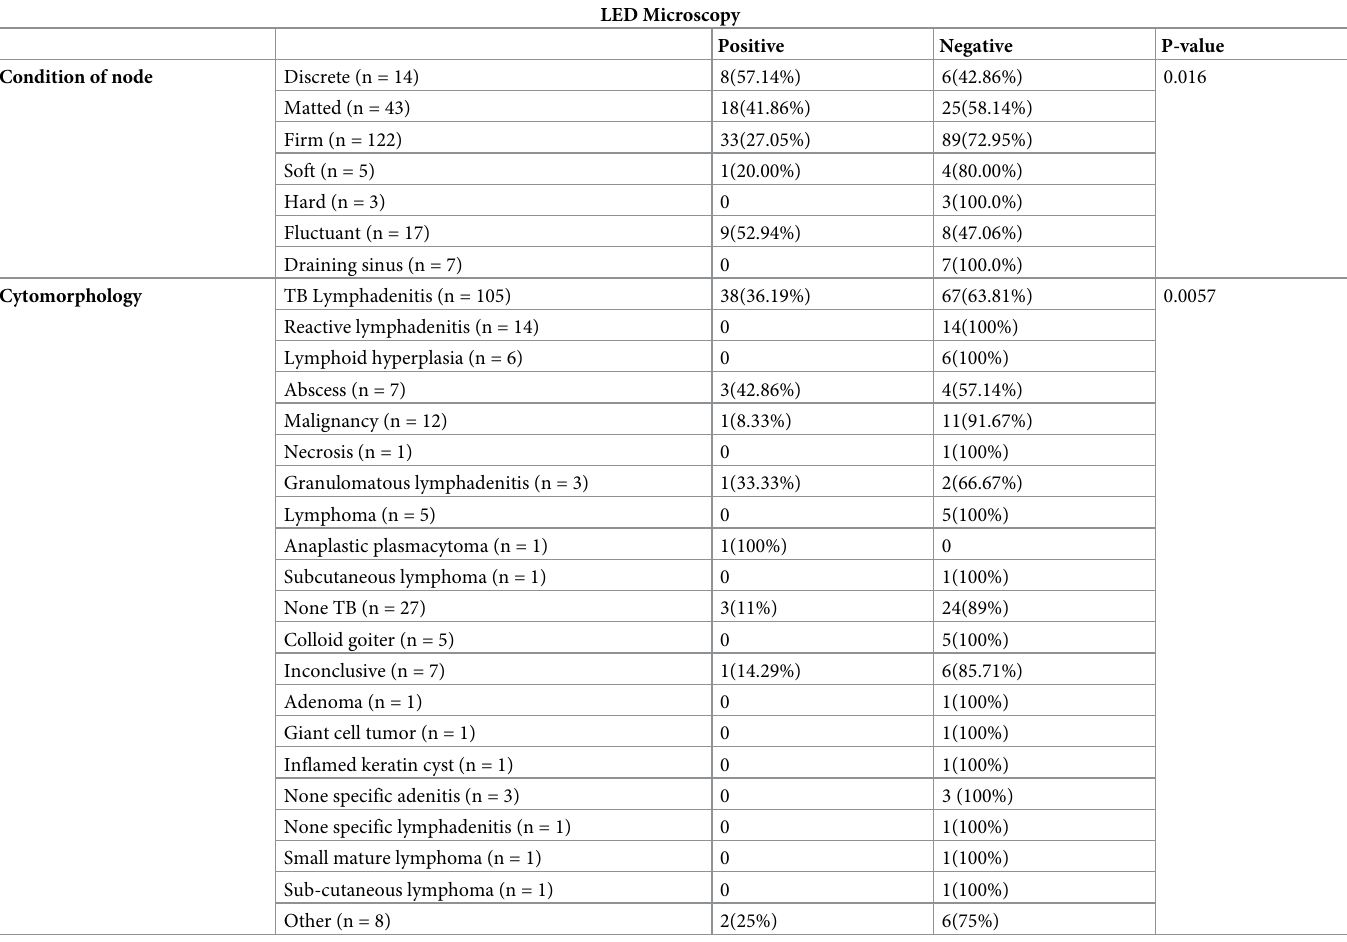
Table 5. Condition of the node and cytomorphological result comparison against LEDFM detection data drowns from ALERT and St. Peter Specialized Hospital, Addis Ababa, Ethiopia (n = 211).